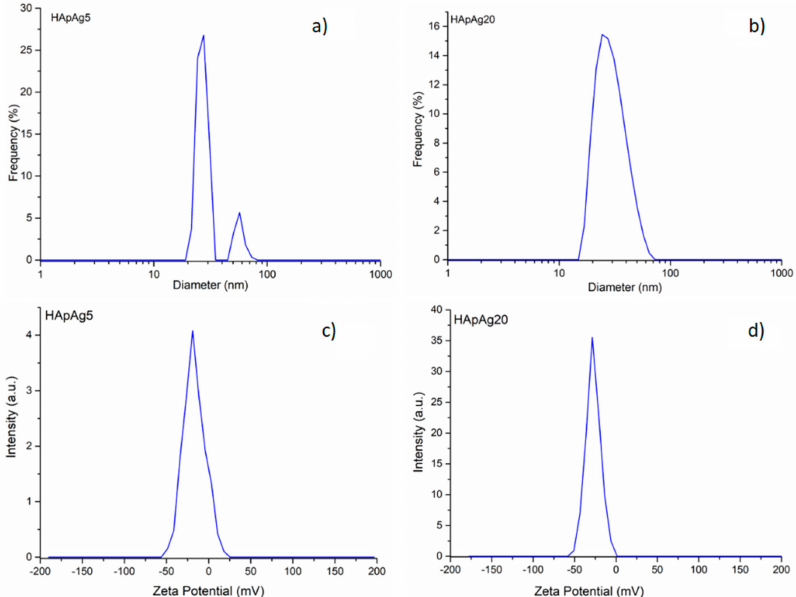
Figure 3. Size distribution of HApAg5 ( a ) and HApAg20 ( b ) suspensions measured by a dynamic light scattering method. Zeta potential for the HApAg5 ( c ) and HApAg20 ( d )